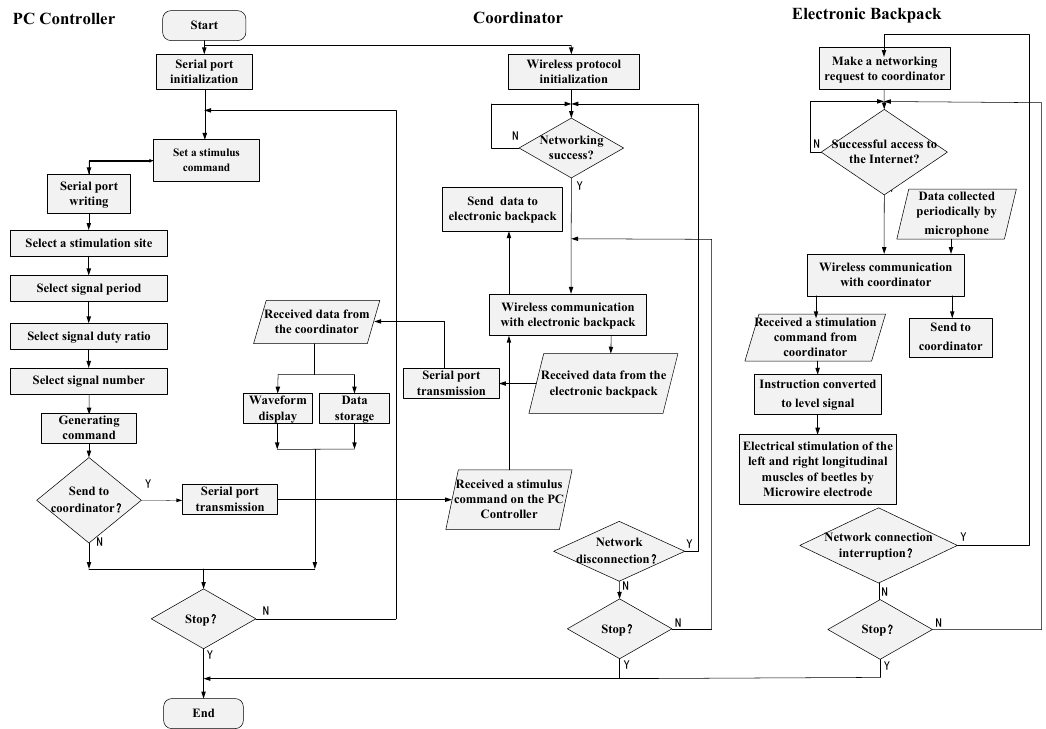
Figure 4. Control algorithm for the micro-control system.